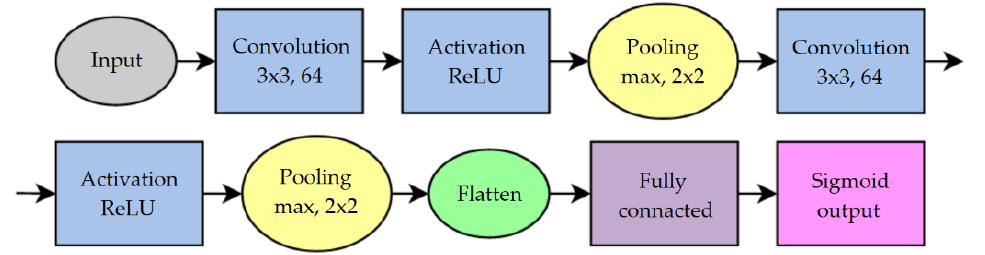
Figure 9. Block diagram of CNN architecture design for binary classification.